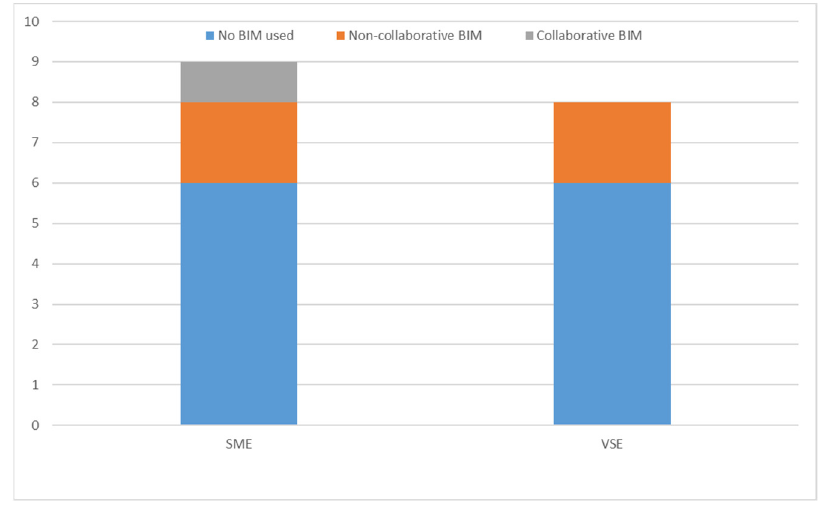
Figure 2. BIM utilization by French energy engineering companies. Table 1. Companies interviewed during ENERJ-MEETING 2020 event in Paris,